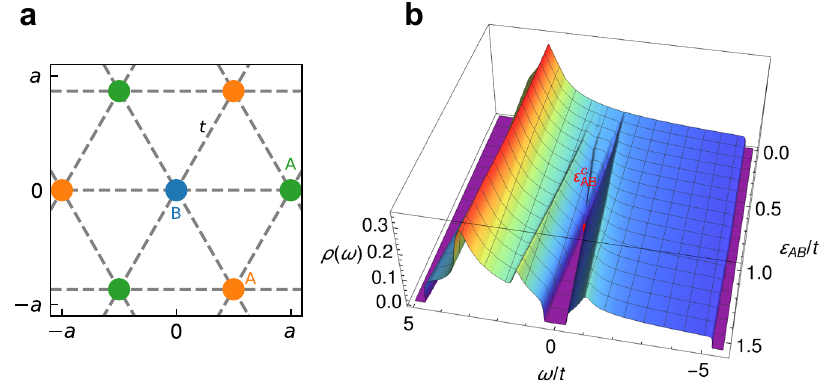
Fig. 2 | Moiré lattice and the density of states. a Triangular lattice with lattice separation ϵ AB ;here ω ismeasuredwithrespecttotheFermienergy.Thebandssplit spacing a ,hoppingparameter t ,andthreesitesinunitcell.Onesitehassiteenergy beyond critical separation ϵ AB > ϵ c AB =0 : 854, producing a continuous ϵ ϵ metal – insulator transition, where all quantities display power-law B (blue dot), while the other two have site energy A (orange and green dots). b Disorder-averagedsingle-particledensityofstatespersite ρ ( ω )fordifferentband